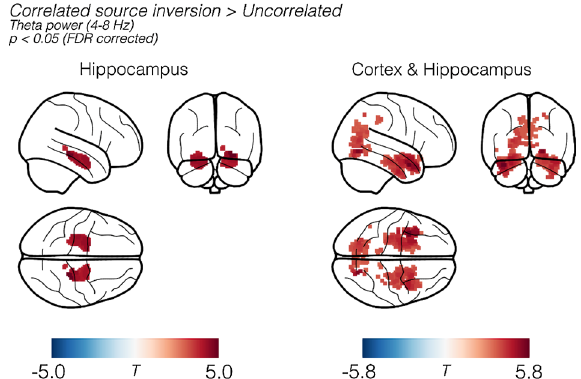
Figure 6. Reconstructed theta band power based on hippocampal only (left panel) and whole-brain (right panel) correlated priors contrasted (paired T-test) against the uncorrelated source model. Left: Comparing uncorrelated to a model containing a correlated hippocampus, we noted a significant increase in theta-band (4–8 Hz) power over the anterior hippocampal areas. Right: Contrasting the whole-brain correlated model with the uncorrelated EBB solution. We observed bilateral anterior hippocampal clusters with significant increases in power in the parahippocampal, rhinal and temporal pole areas. Results have been tranformed into MNI space for visualisation